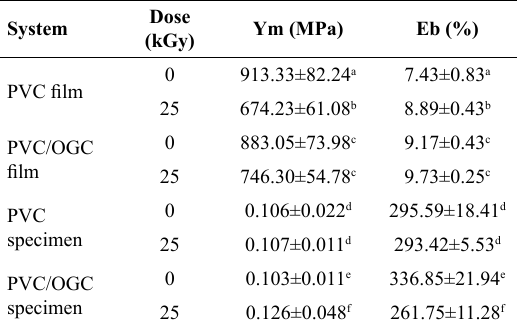
Table 4. Effects of OCG ( 0.5 wt%) and gamma irradiation in the mechanical properties of PVC Dose System